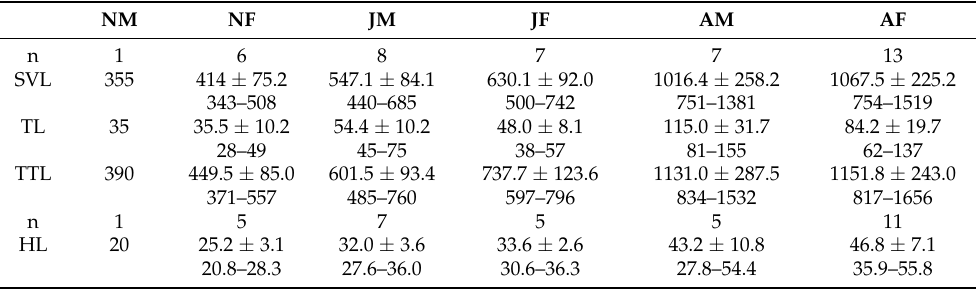
Figure 3. Monthly percentages of prey items of Tehuantepec Isthmus rattlesnake ( Crotalus ehecatl ). Numbers in parentheses are specimens found per month. Note the high number of specimens found in the rainy season (May–October). Table 2. Sample sizes (n), mean ( ± standard deviation), and range (below means) of snout-vent length (SVL, mm), tail length (TL, mm), total length (TTL, mm), and head length (HL, mm) of newborn, juvenile, and adult Tehuantepec Isthmus rattlesnake ( Crotalus ehecatl ) specimens. Abbreviations are: NM = newborn male, NF = newborn female, JM = juvenile male, JF = juvenile female, AM = adult male, AF = adult